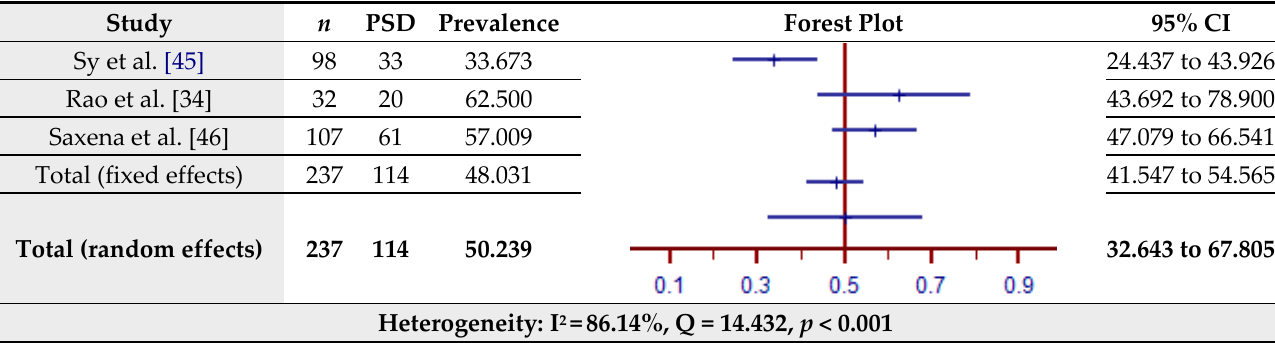
Figure 8. Prevalence estimates of post-stroke depression (PSD) assessed by the Montgomery–Asberg Depression Rating Scale (MADS).